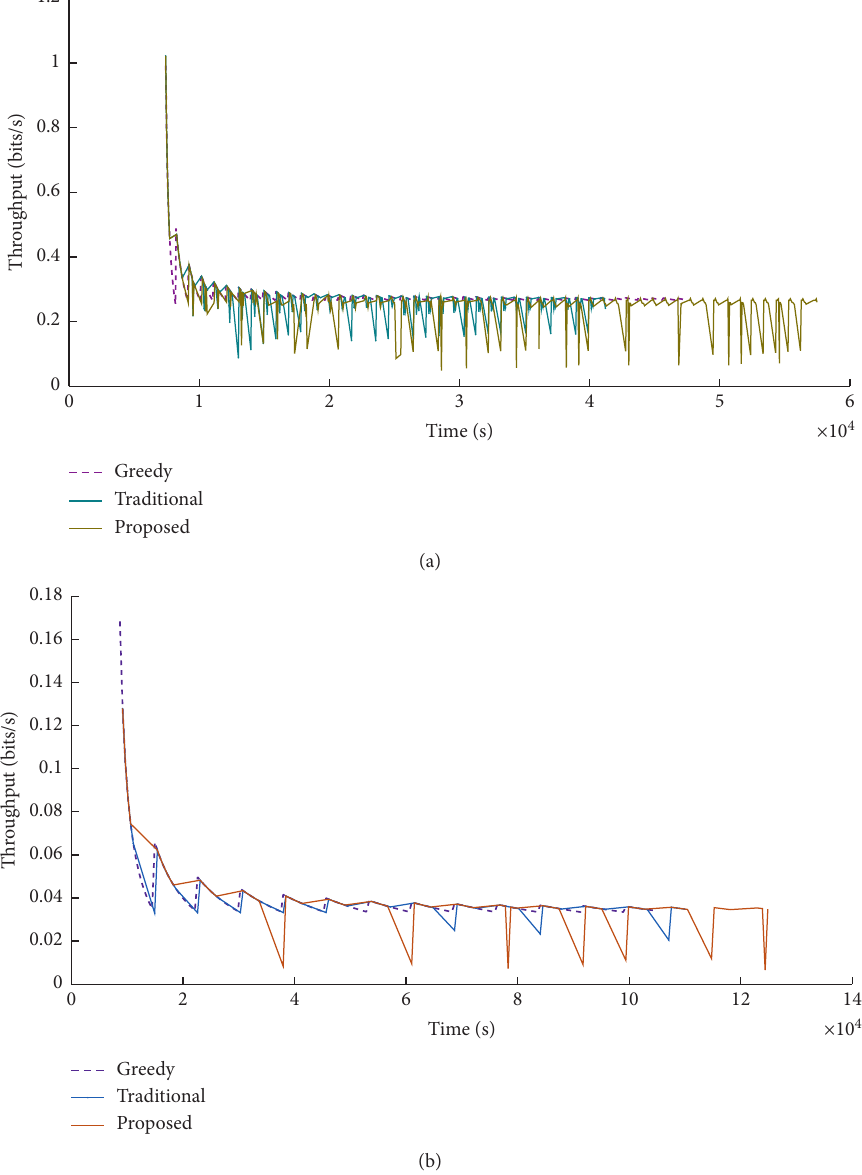
Figure 5: Comparison of the network throughput among the traditional technique, greedy technique, and proposed technique. (a) Transmission interval 1 minute. (b) Transmission interval 8 minutes. Traditional technique does not use load-balancing algorithms, and its lifetime is short than the proposed